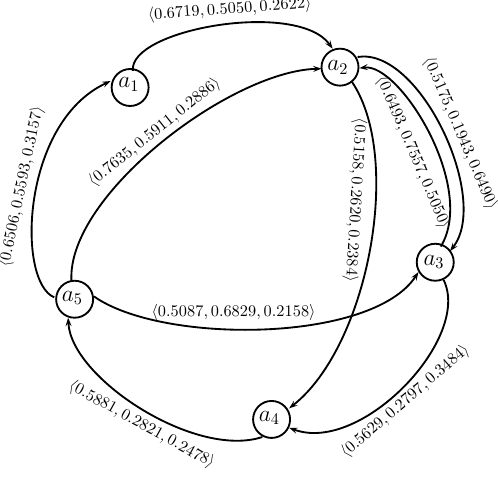
Figure 7. Partial directed network of the fused